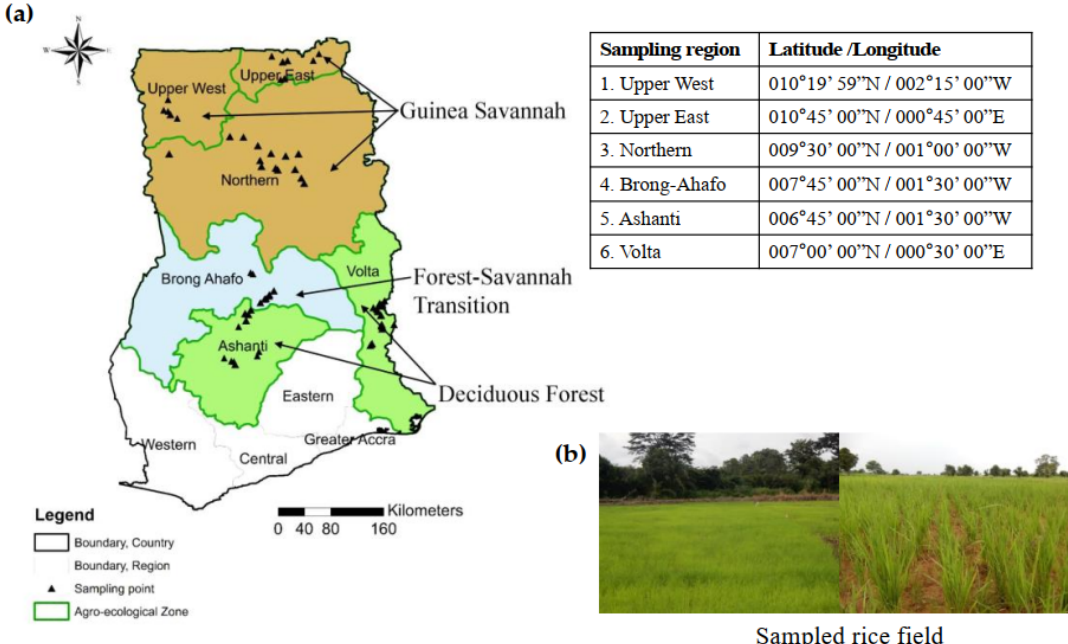
Figure 1. Sampling sites in rice-cultivated fields of Ghana with the study area colored in three different colors. ( a ) The map shows 57 sampling areas marked with black triangles among six different regions under three agroecological zones of Ghana. ( b ) Pictures of rice fields in Ghana where samples were collected.